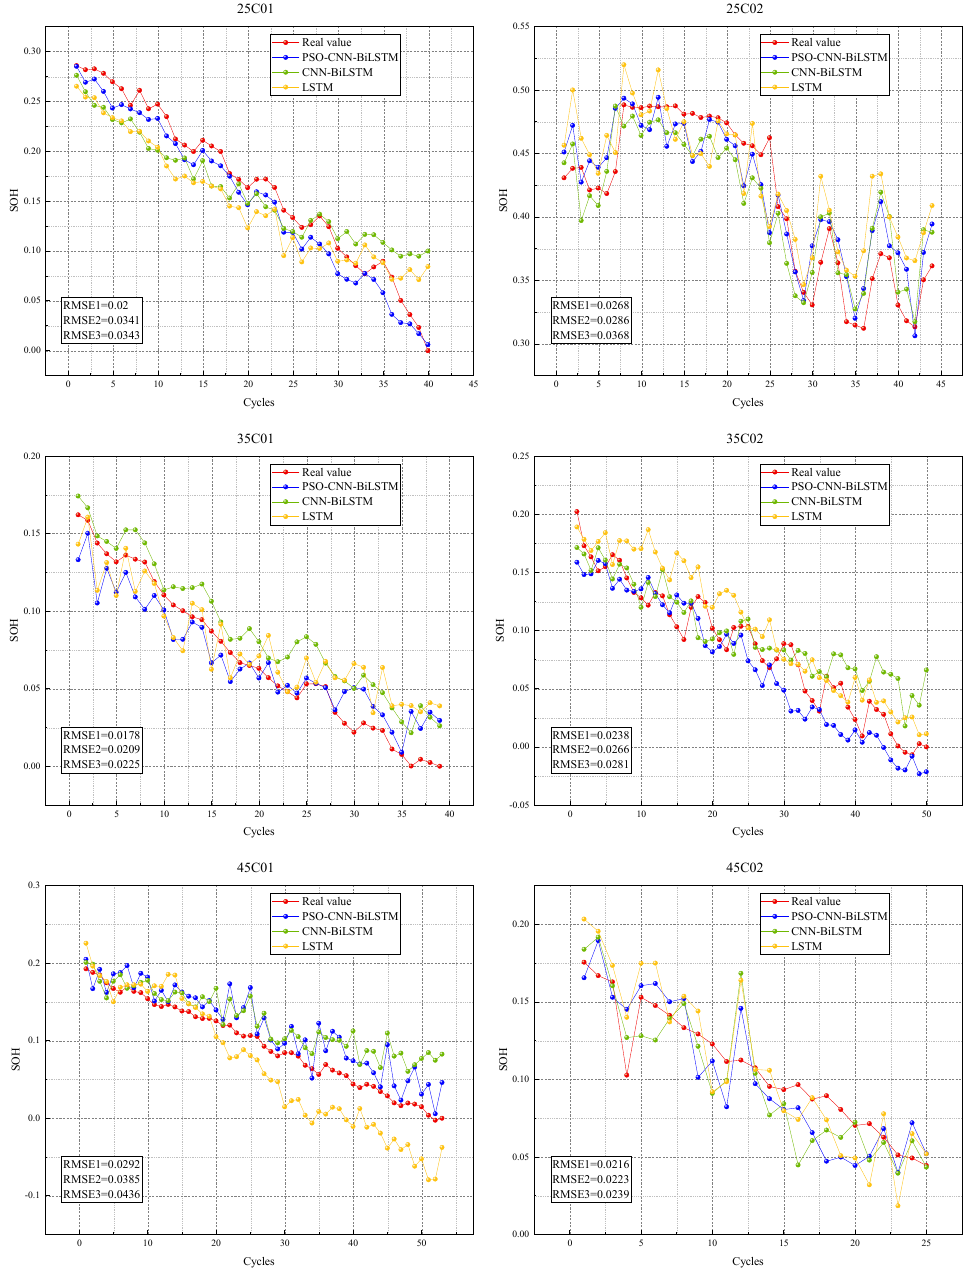
Figure 9. Comparison prediction results of different models for LIBs.